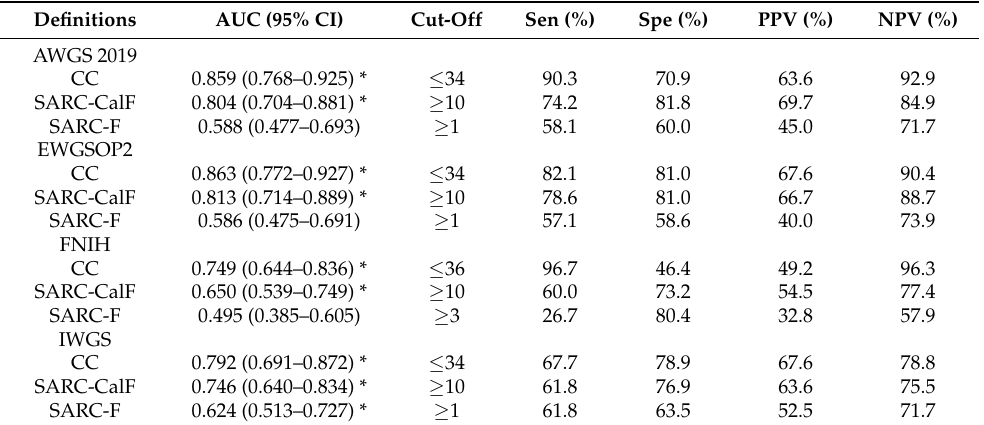
Table 5. The diagnostic performance of SARC-F, SARC-CalF, and CC on sarcopenia based on four operational definitions in male patients undergoing